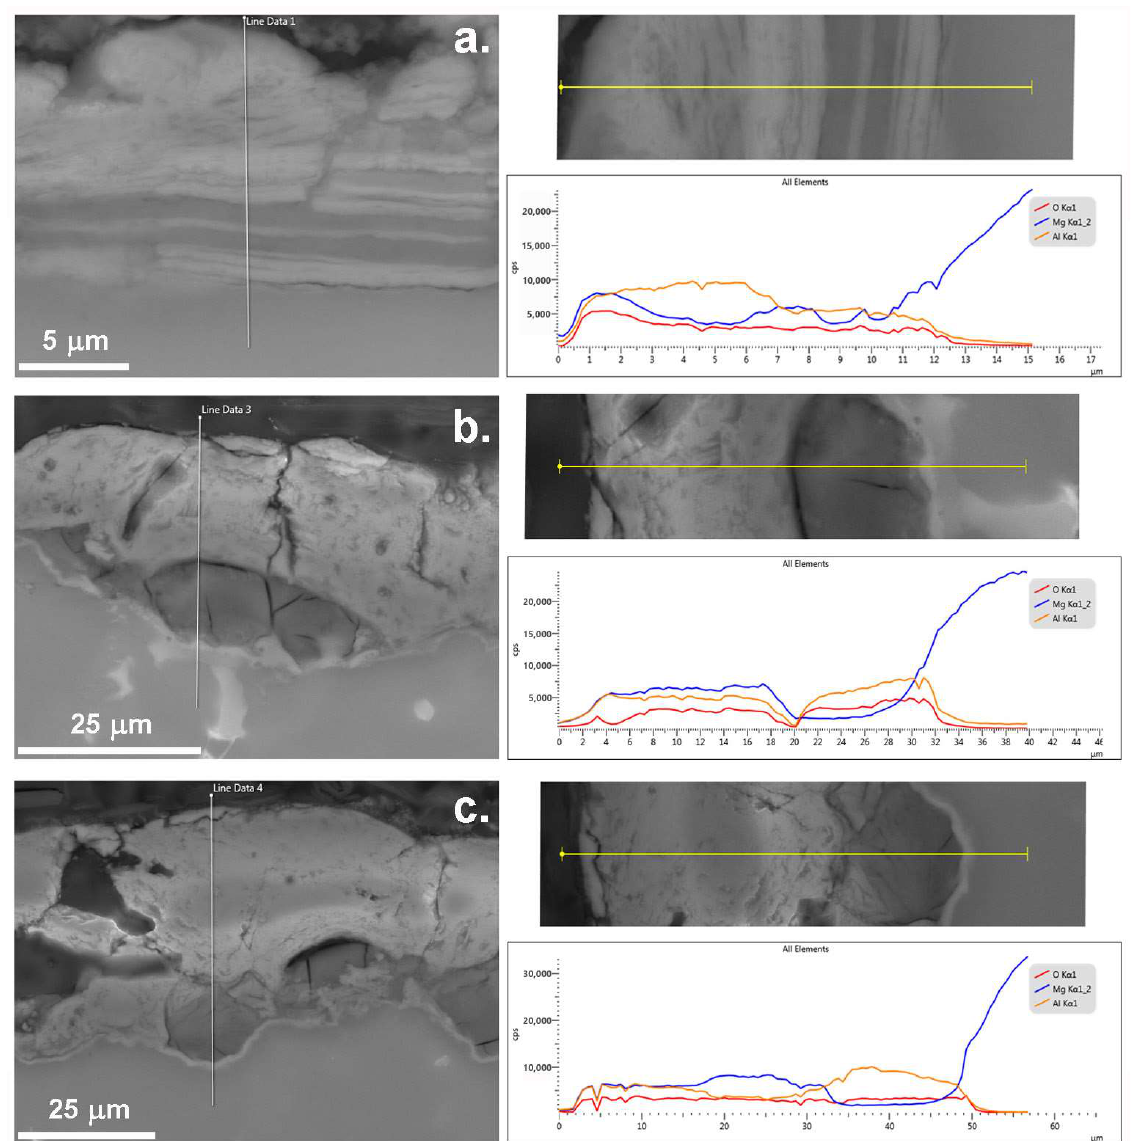
Figure 7. Cross-section EDS line-scan analysis for sample AZ63_5m ( a ), AZ63_10m ( b ) and AZ63_20m ( c ).